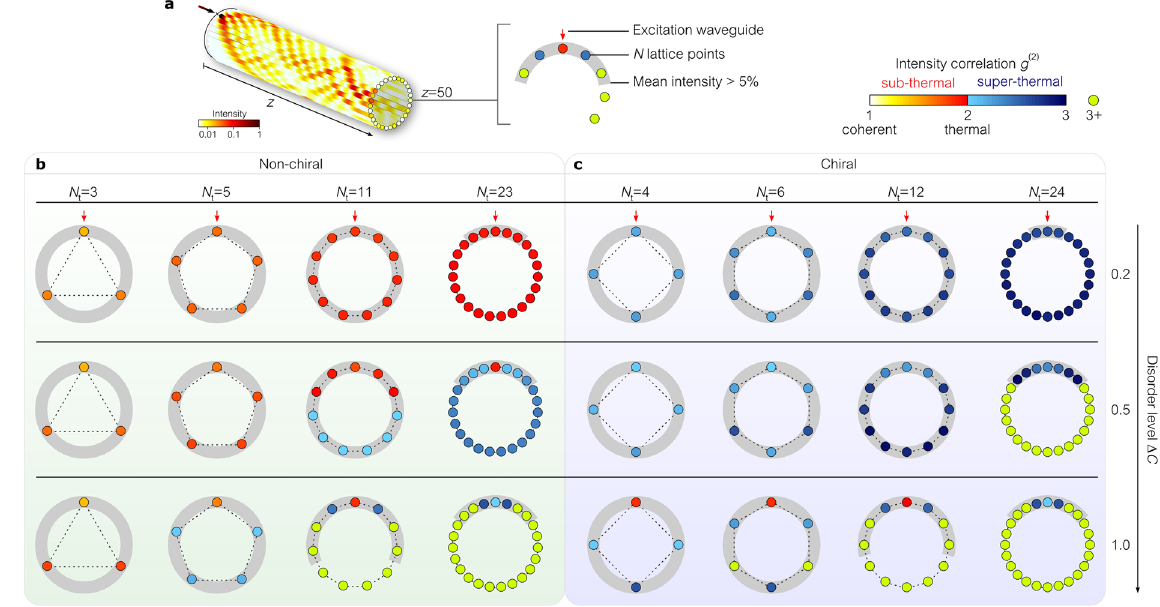
Figure 6. Normalized intensity correlation g (2) in ring lattices with off-diagonal disorder. ( a ) Evolution of the intensity on a ring lattice in a single realization of disorder. The arrow identifies the input site. ( b ) g (2) at the output of odd-sited ring lattices, which lack chiral symmetry. The color in the small circles (corresponding to the lattice points) depicts the normalized intensity correlation g (2) . The field statistics are mainly sub-thermal. In the off-set waveguides the statistics may become super-thermal, but this comes with a reduction in intensity. The two regimes of sub-thermal and super-thermal photon statistics are denoted by different color palettes. The red arrow identifies the excitation site. The gray shading encompasses the lattice sites with the mean intensity exceeds 5% of the input power. ( c ) g (2) in even-sited ring lattices with chiral symmetry. The statistics are mainly super-thermal. At offset waveguides, g (2) may take very high values at the expense of low